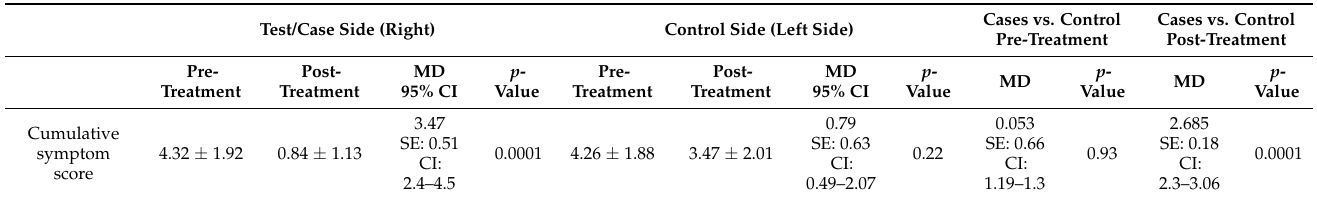
Table 4. The cumulative symptom scores pre- and post-treatment of the right (test) and left (control) sides of the